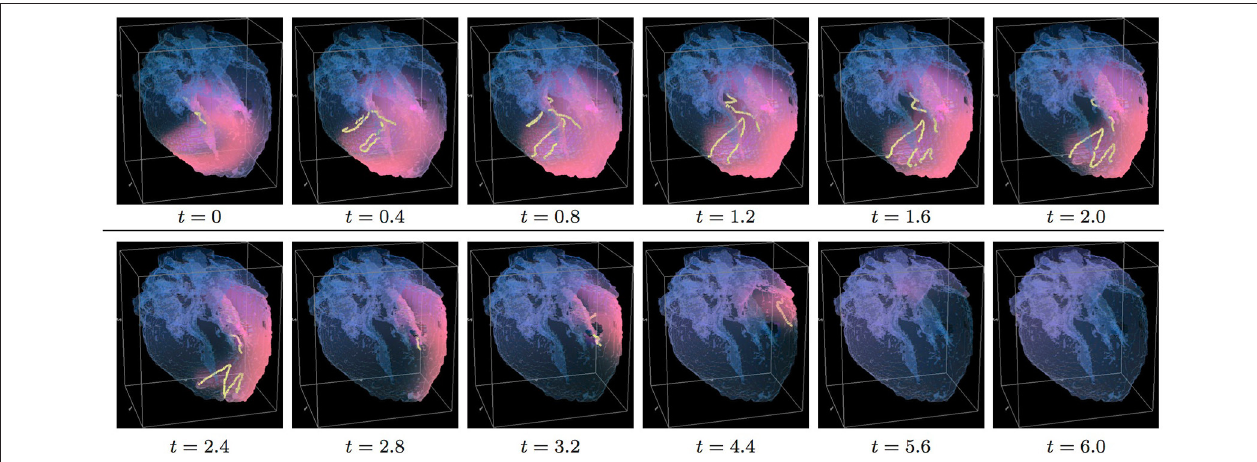
FIGURE 8 | Anisotropic “edited” whole heart simulation. The translucent fetal heart is shown in blue, excitation front shown in red (see the color box in Figure 3 ), the yellow lines are the instant organizing filaments of the excitation vortices; time shown under each panel in time units of Equations (1, 2). The anisotropy of the heart causes the significant transient distortion of the organizing filament of the initial vortex, followed by its fast drift toward the apex and the ultimate termination before completing a single rotation (See Supplementary Video 8 ).